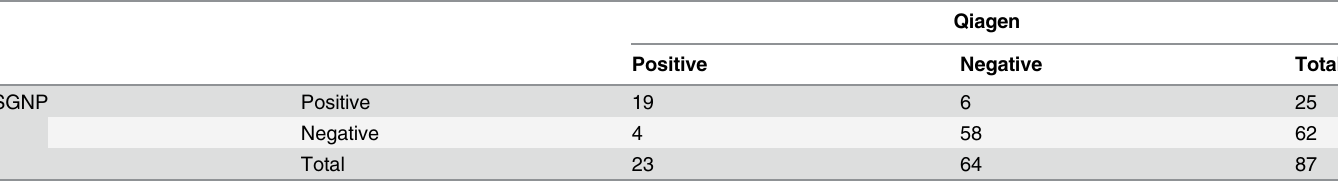
Table 3. Positive test results and comparison between the SGNP (sulfated sugar chain-immobilized gold nanoparticles) method and the Qiagen